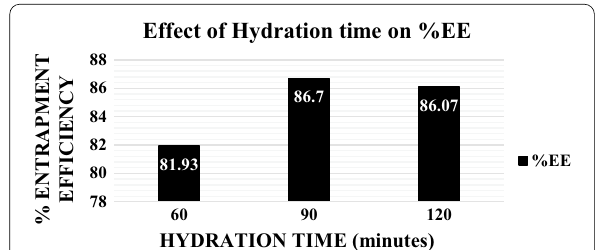
Fig. 6 Graphical comparison of effect of hydration time on